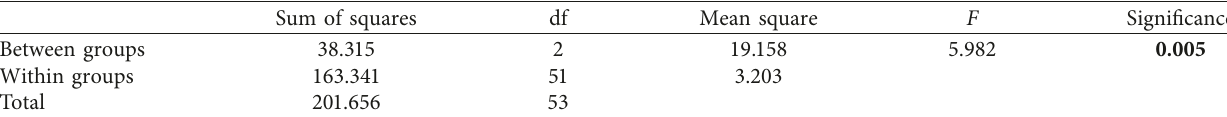
Table 9: One-way ANOVA for the delayed posttest scores.